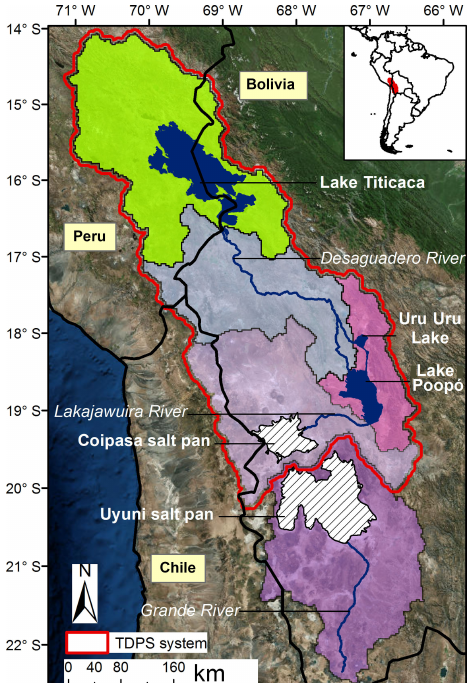
Figure 1. Lake Titicaca and the TDPS system within the